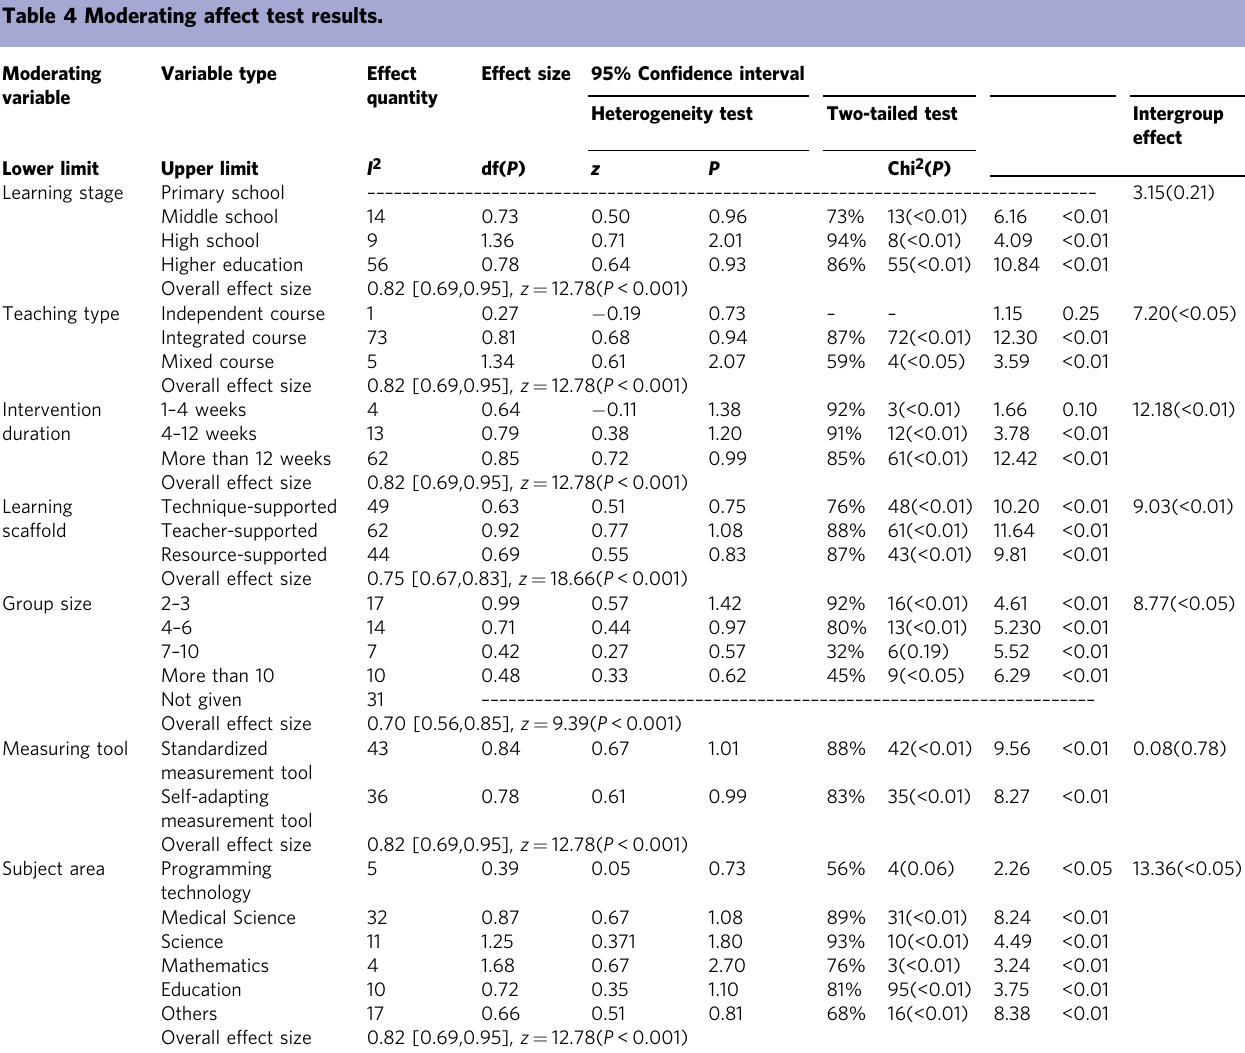
Table 4 Moderating affect test